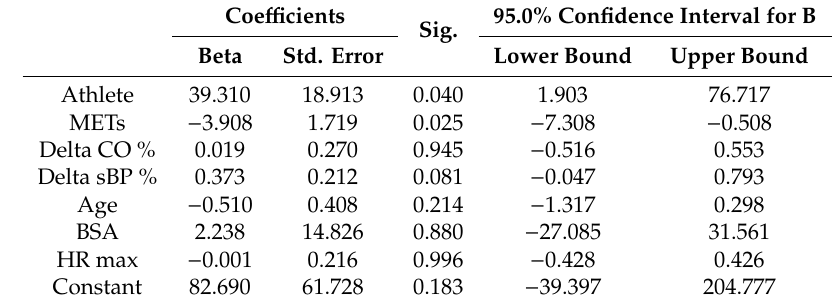
Figure 7. Trans-pulmonary gradient as assessed by ePLAR response in age matched controls, athletes and general community cohort populations, pre- and post-exercise. The box and whisker plots depict the minimum, first quartile, median, third quartile and maximum values of each data set. The change in ePLAR from pre- to post-exercise is shown for the three groups, with standard deviations and p -values. The change in ePLAR between all groups is also shown, with p -value. Table 3. Multiple linear regression results for predicting ∆ ePLAR from athlete status, METS (metabolic equivalents), age, BSA (body surface area), ∆ sBP (systolic blood pressure), HR max (maximum heart rate) and ∆ CO (cardiac output). Only athlete status and METS (negative e ff ect) significantly influenced ∆